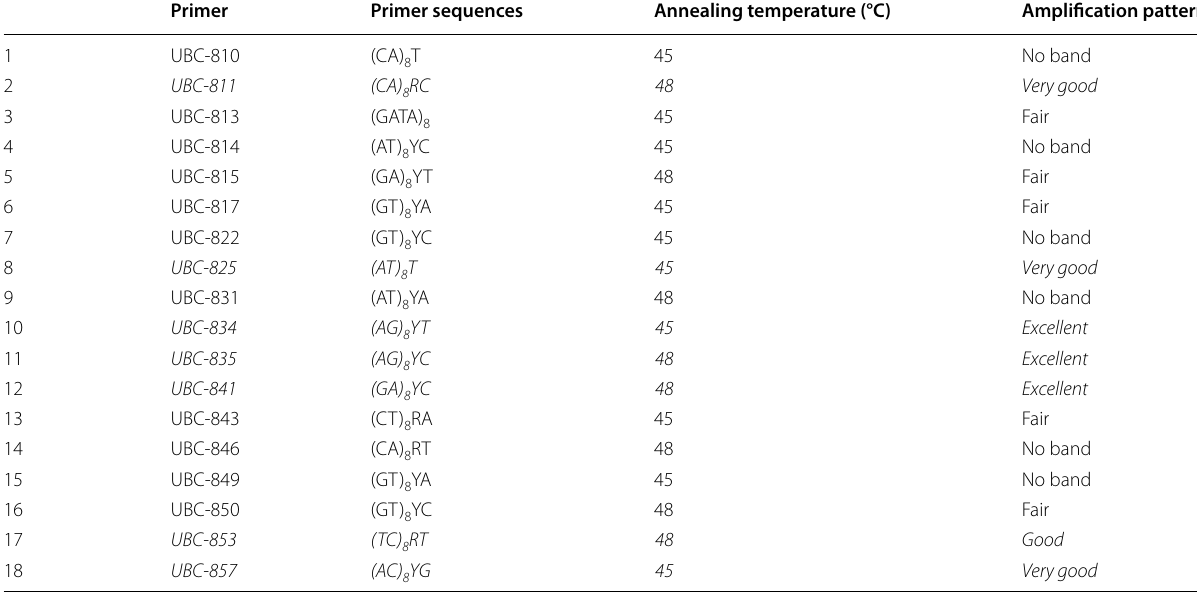
ISSR primers (UBC 1–18) were from the University of British Columbia, Canada. The seven primers used in the present study for PCR amplification are highlighted in